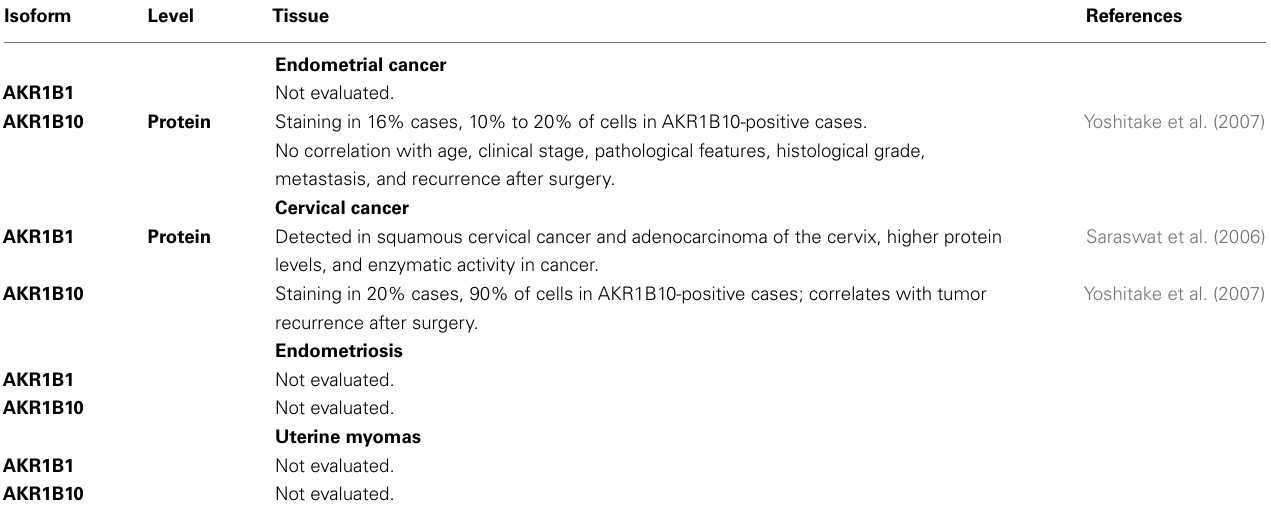
Table 3 | Expression of AKR1B1 and AKR1B10 in uterine